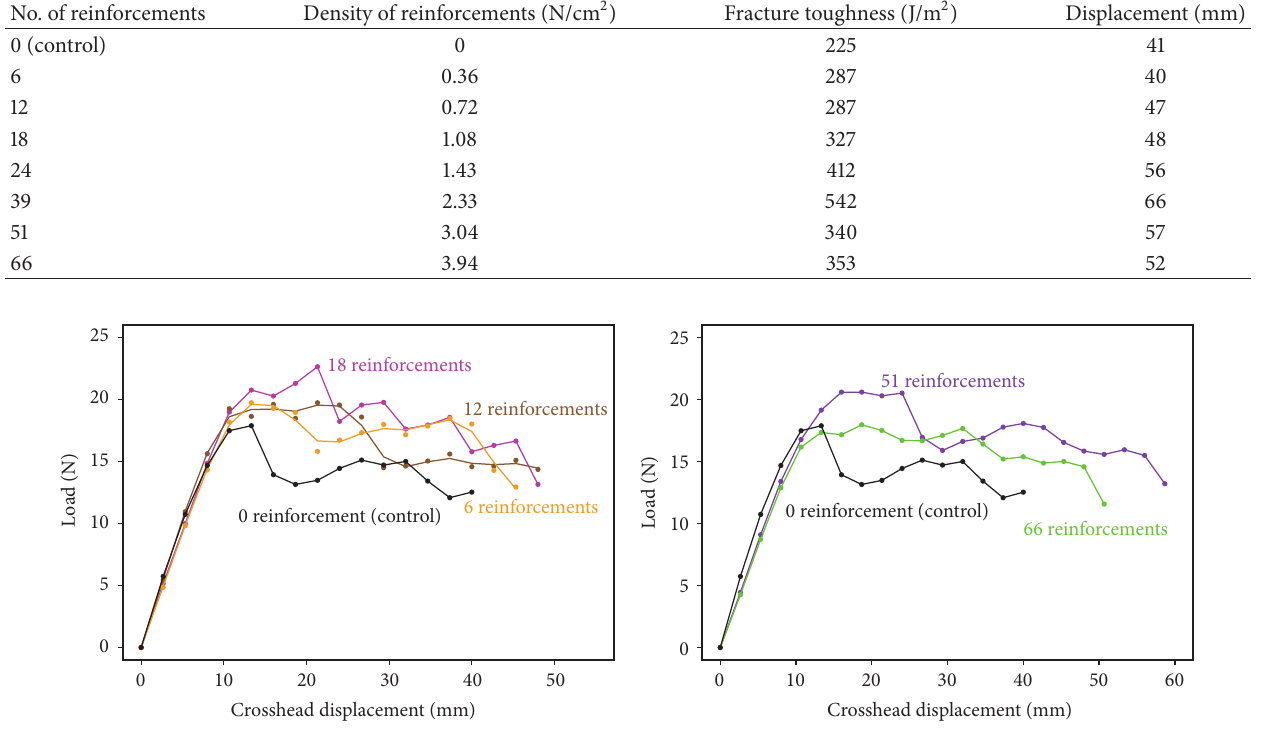
Table1:Effectsofdifferentlevelsofadhesivethrough-reinforcementonthefracturetoughnessandmodeIopeningdisplacementoflaminated birch wood specimens bonded with an unmodified polyurethane adhesive.